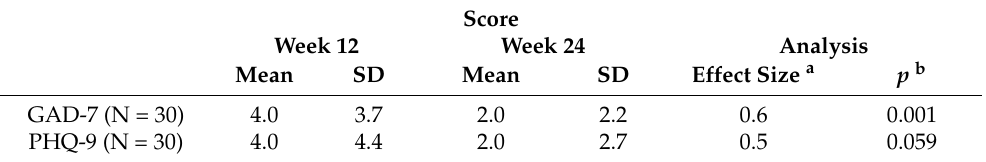
Table 4. Scores at Post-test and the Follow-up 12 Weeks after the End of Self-Attachment Intervention. Score Week 12 Week 24 Analysis Mean SD Mean SD Effect Size a p b GAD-7 (N =